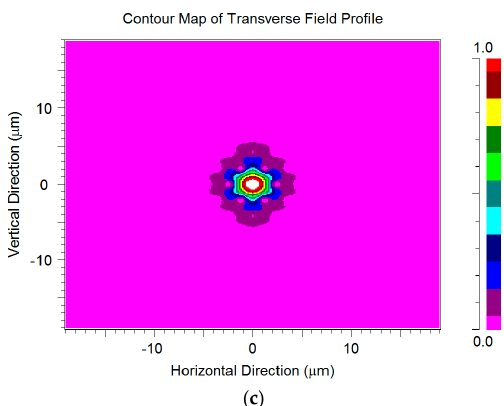
Figure 4. The 4 × 1 power combiner of the optical signals ( λ = 1 µm) of three xy cross sections: ( a ) z = 0 mm, ( b ) z = 1 mm; ( c ) z = 2.6 mm.